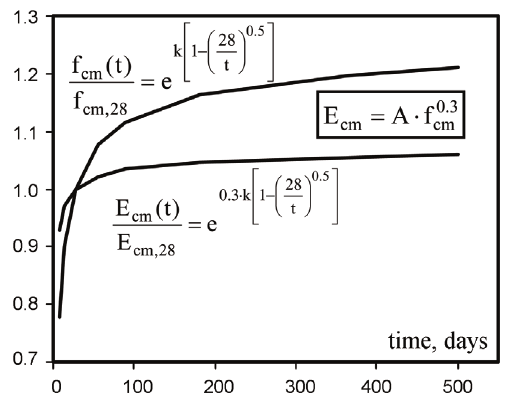
7. Development of strength and Young’s modulus of concrete in time (CEB